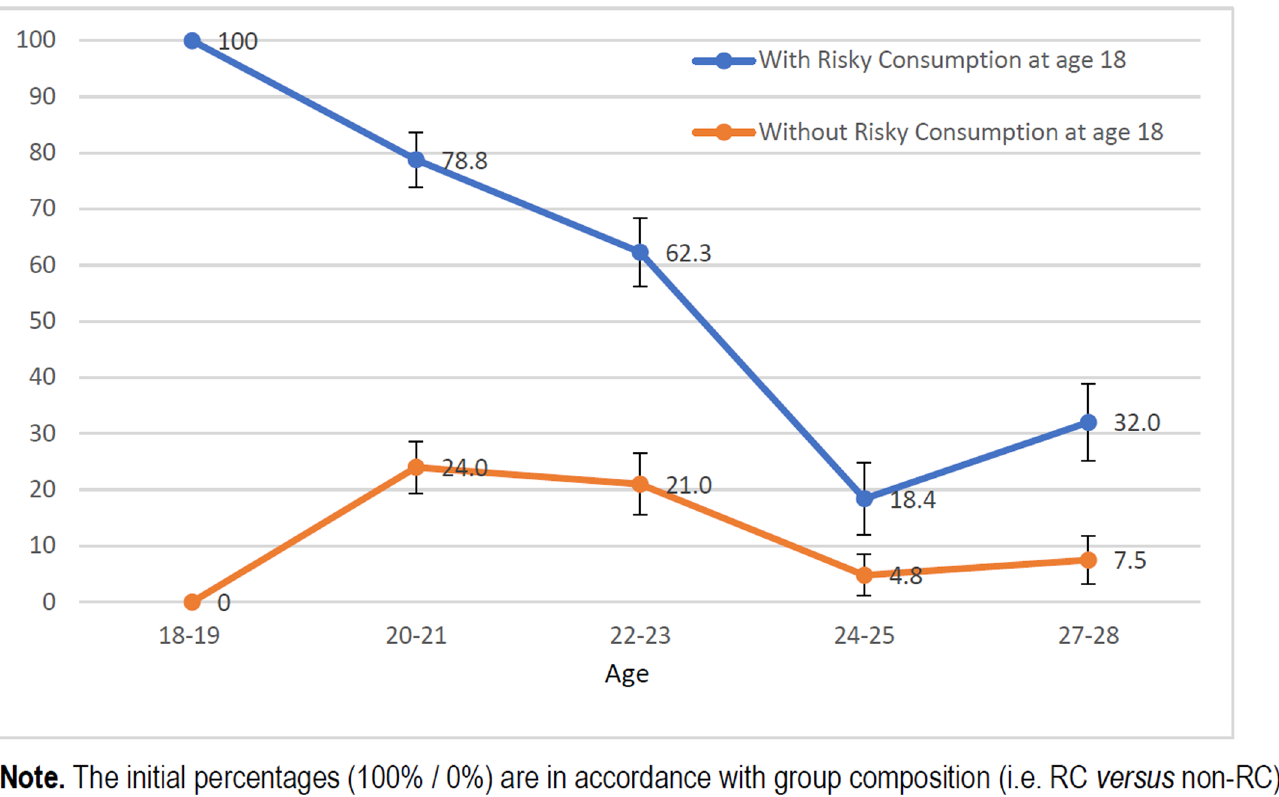
Fig 1. Trends in prevalence of risky consumption (%) among women who already partook and who did not partake in risky consumption at age 18–19.